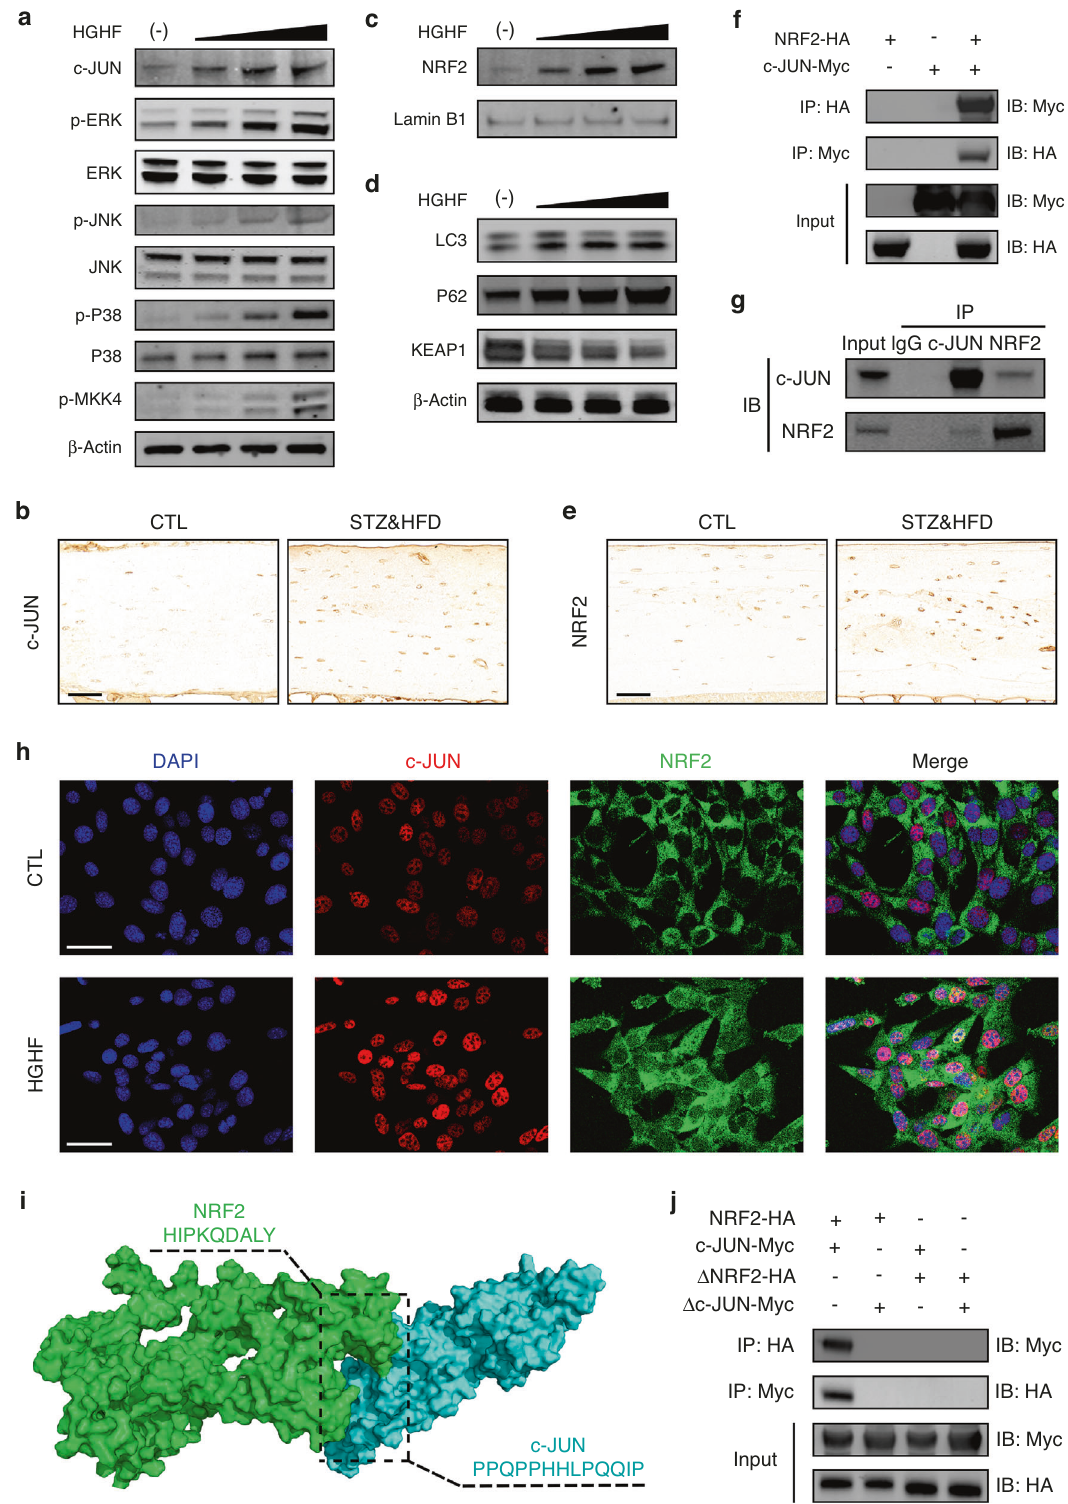
Fig. 5 HGHF enhanced the NRF2 – c-JUN interaction. a Effects of HGHF on the levels of MAPK signaling pathway proteins, including p-MKK4, p ‐ p38/p38, p ‐ JNK/JNK, p ‐ ERK/ERK, and c-JUN. b Representative images of bone sections stained with an anti-c-JUN antibody (scale bar: 50 μ m). c Effects of HGHF on nuclear import of NRF2. d Effects of HGHF on NRF2 upstream signaling pathway proteins, including LC3, P62 and KEAP1. β -Actin was used as the internal control for cytoplasmic proteins, and Lamin B1 was used as the internal control for nuclear proteins. e Representative images of bone sections stained with an anti-NRF2 antibody (scale bar: 50 μ m). f Co-IP results for NRF2 and c-JUN in osteocytes transfected with the NRF2-HA and c-JUN-Myc plasmids. g Co-IP results for endogenous NRF2 and c-JUN in osteocytes. h IF showing that NRF2 colocalized with c-JUN in the nucleus in osteocytes under HGHF treatment (scale bar: 50 μ m). i 3D binding structure of NRF2 and c-JUN determined via molecular modeling and docking studies. j Co-IP results for Δ NRF2 and Δ c-JUN in osteocytes transfected with plasmids expressing the NRF2-HA and c-JUN-Myc truncations. All data are from n = 3 independent